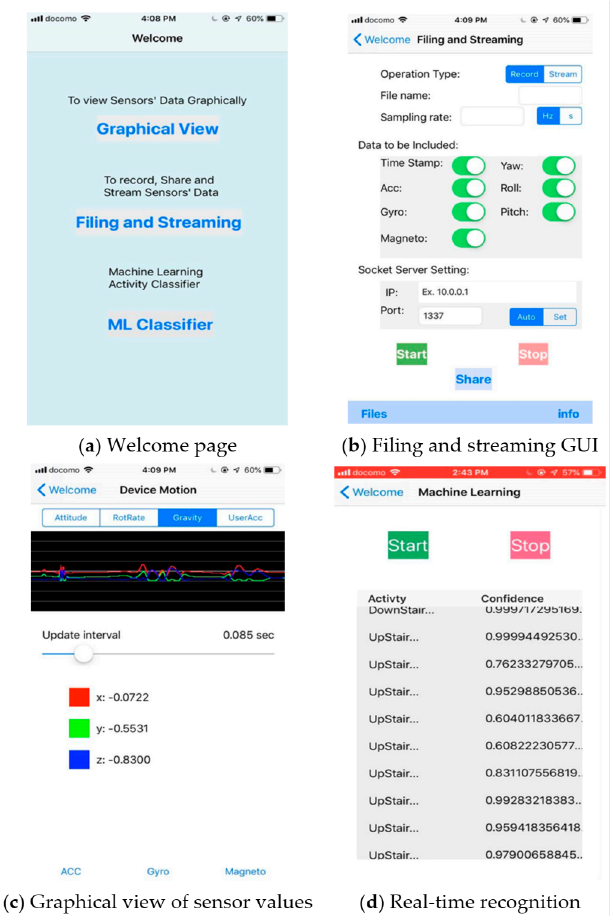
Figure 5. Graphical user interface of the iOS application software